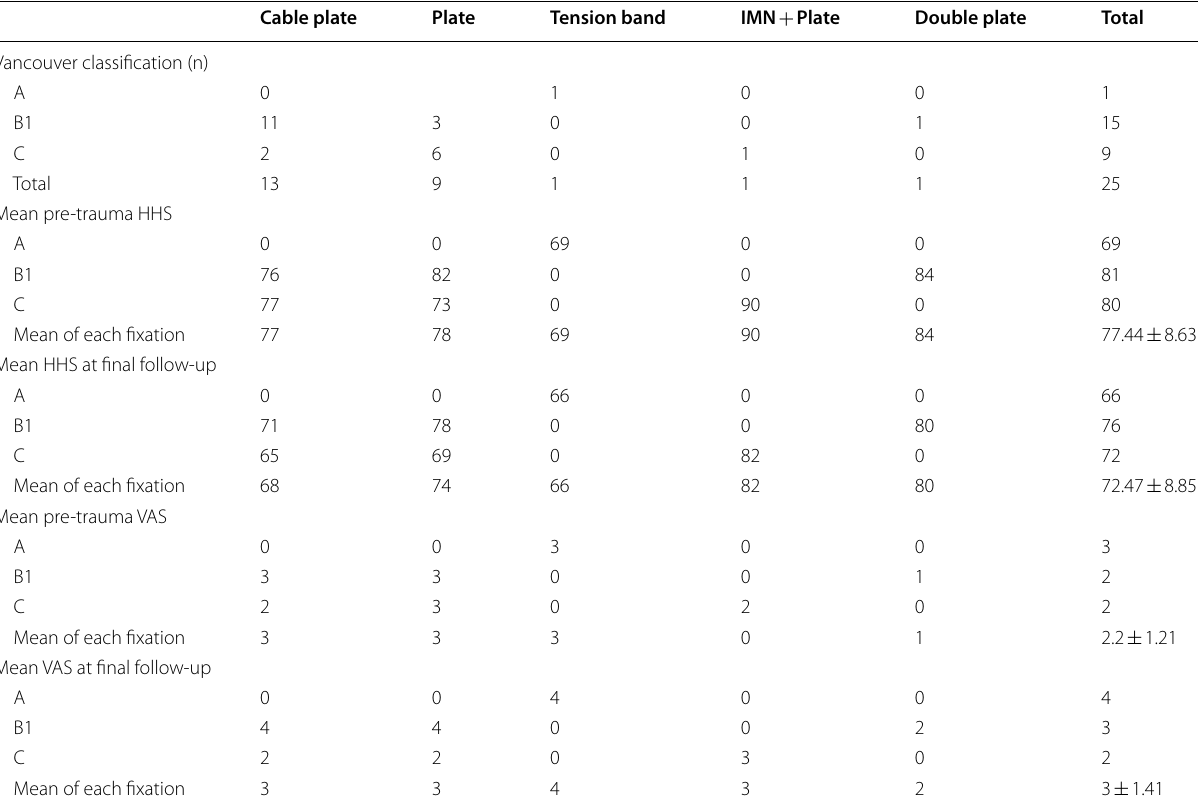
Table 2 Detailed fixation techniques and assessments in 25